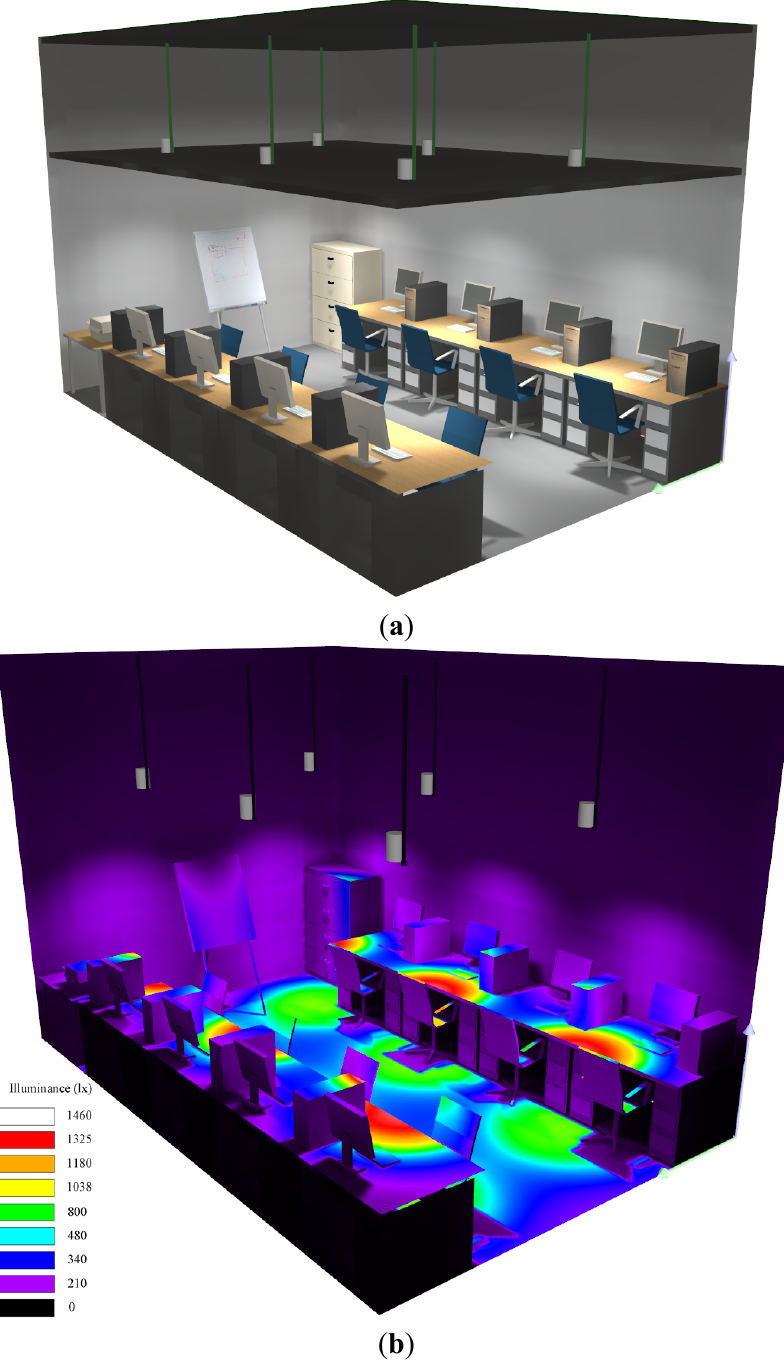
Figure 7. Illuminance distribution in the interior ( a ) lighting view ( b ) false color